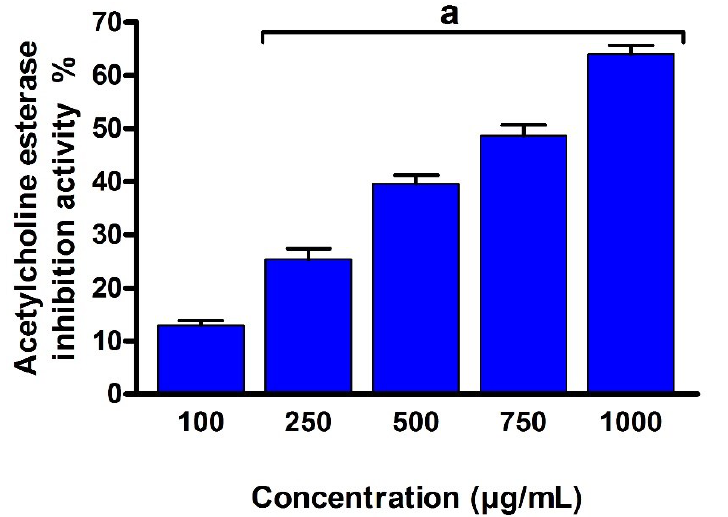
Figure 14. Evaluation of the inhibitory activity of EPSR4 against acetylcholinesterase activity. Data are presented as mean ± SD. a p < 0.05 versus concentration of 100 μg /mL.